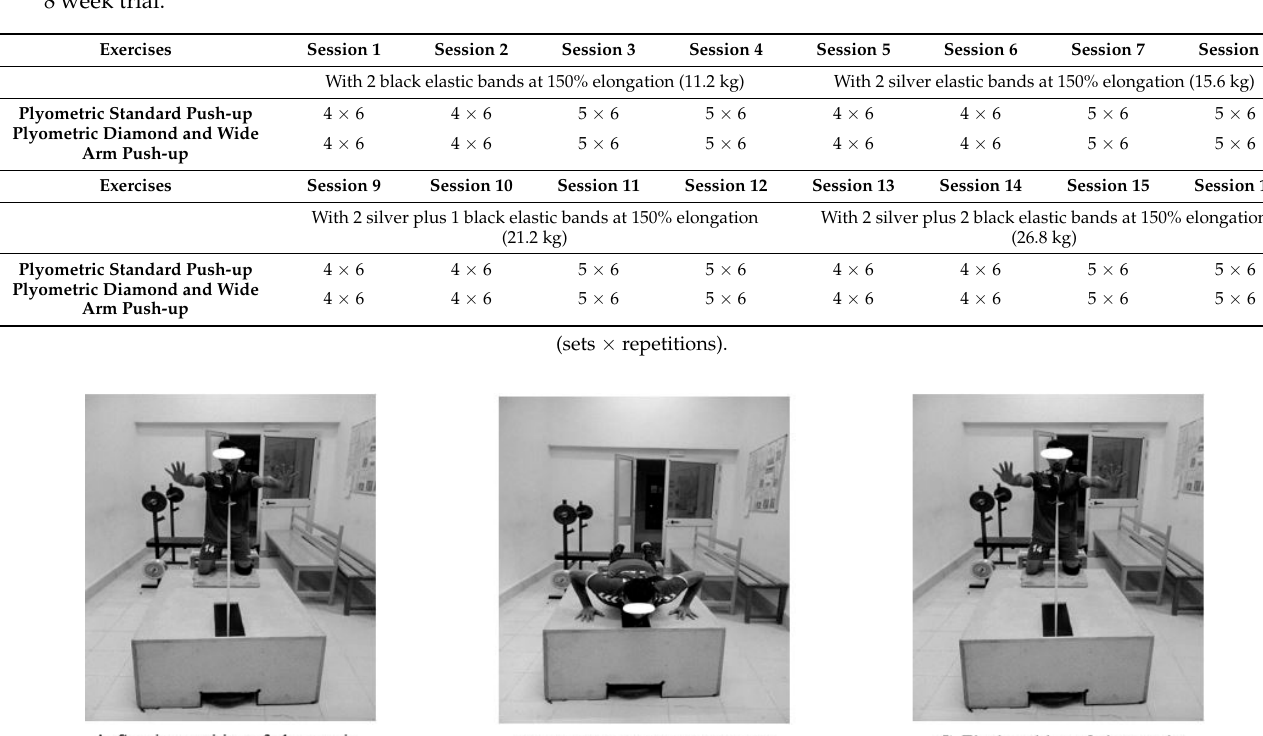
Table 1. Details of loaded the plyometric (elastic band) training program performed by the experimental group over the 8 week trial.